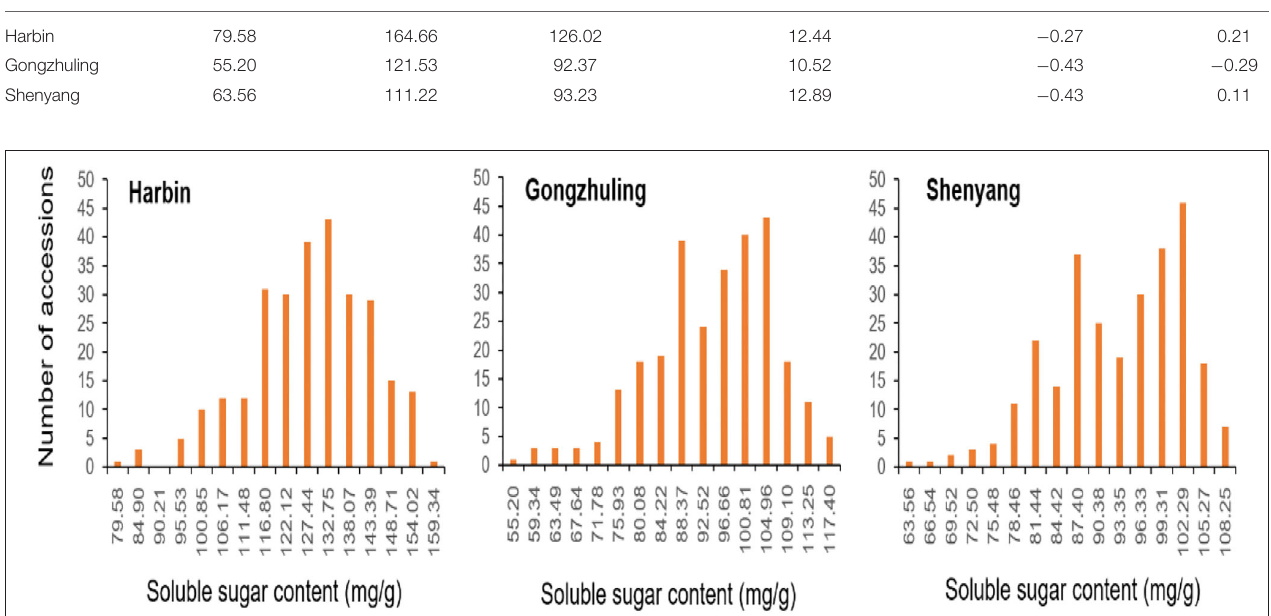
Frontiers in Plant Science |